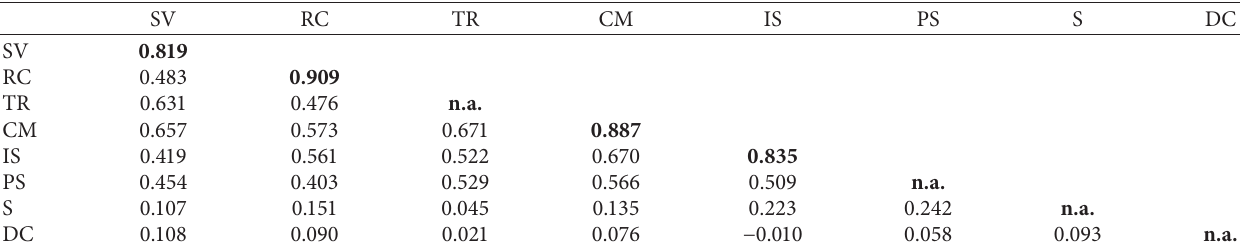
Table 10: Measurement model: discriminant validity.